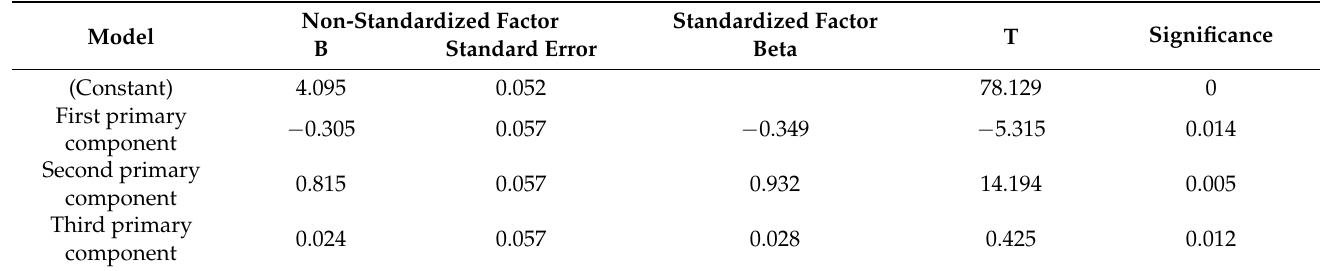
Table 6. Regression coefficient.